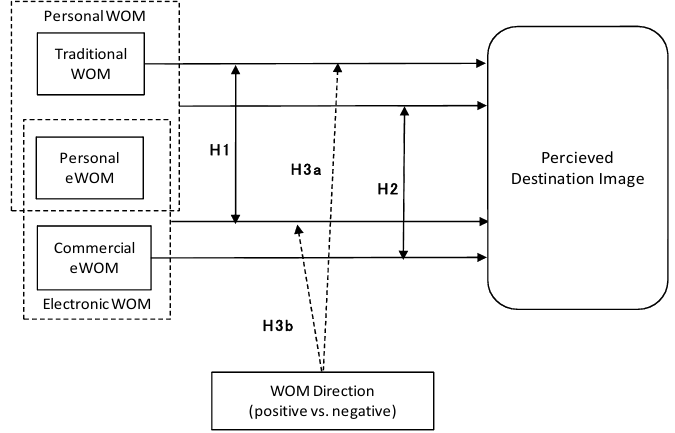
Figure 1. Integrated Model of Effects of Traditional and Electronic WOM on Destination Image.